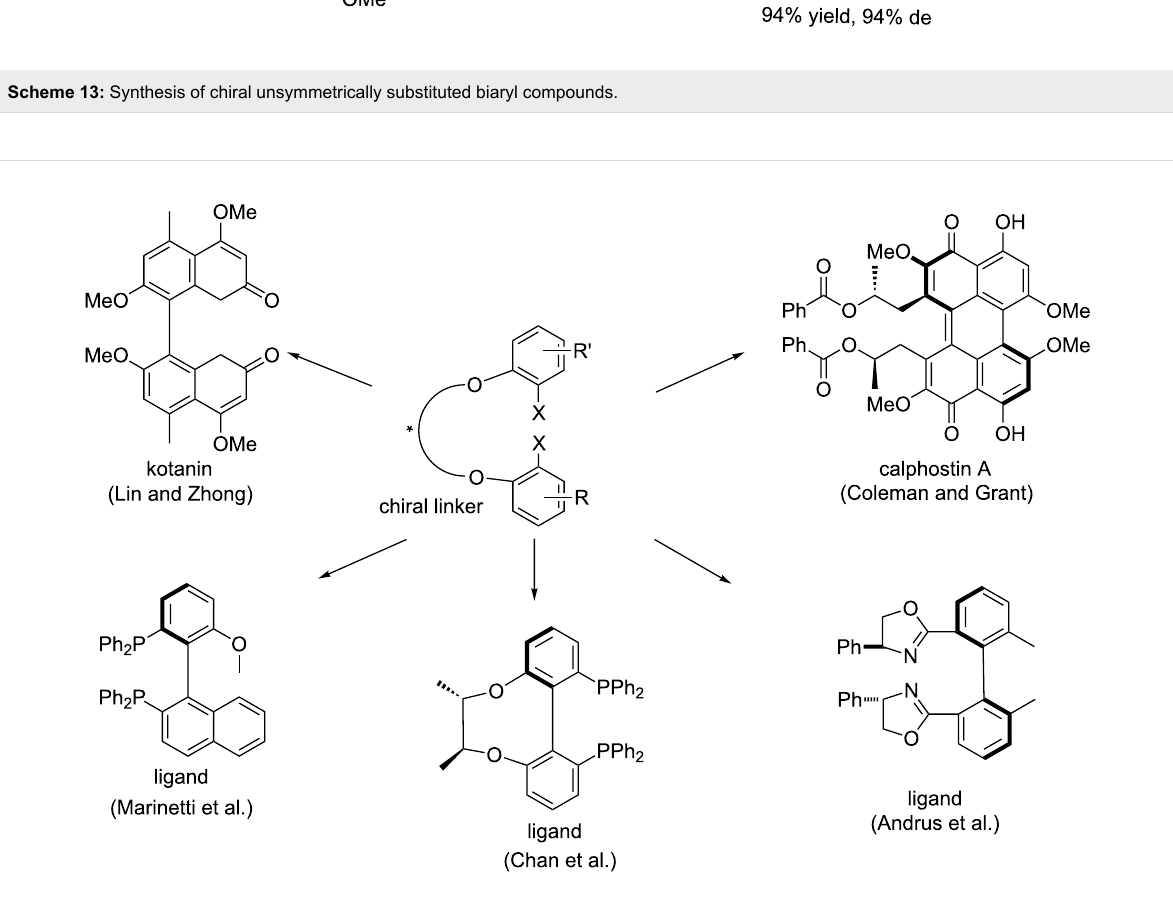
Scheme 14: Atroposelective synthesis of biaryl ligands and natural products by using a chiral diether